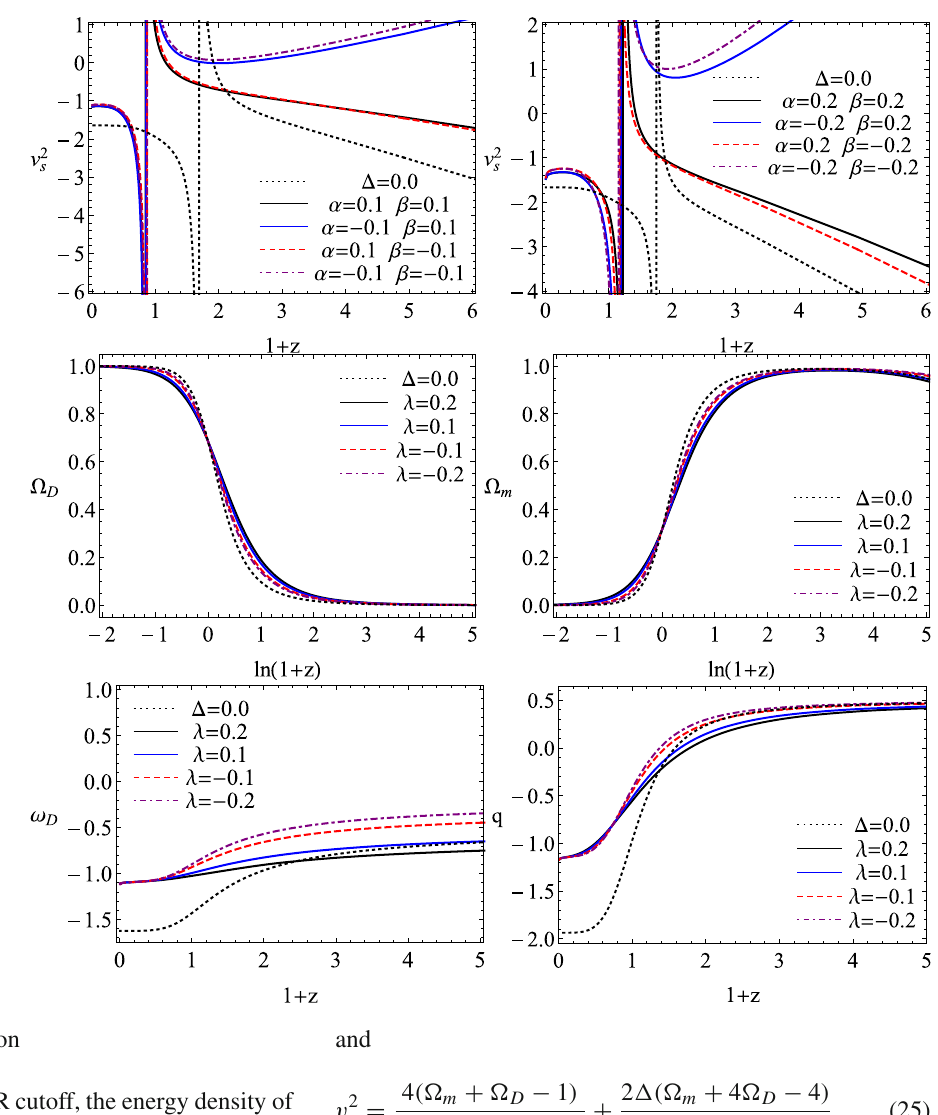
Fig. 8 Evolution curves of w D and q versus redshift parameter 1 + z for